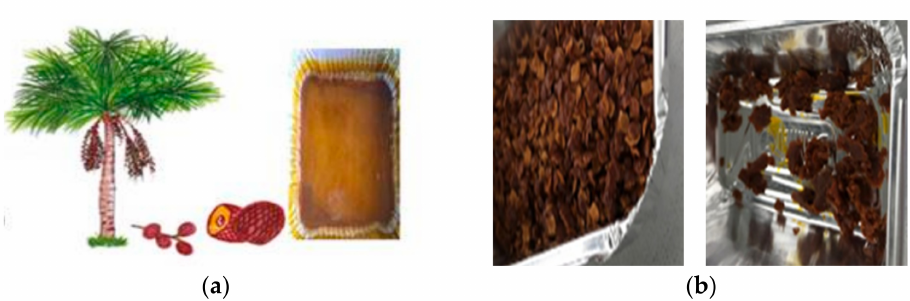
Figure 1. ( a ) Mauritia flexuosa (aguaje) palm and fruit (seedless pulp) [2]. ( b ) Dehydrated aguaje samples, seeds and